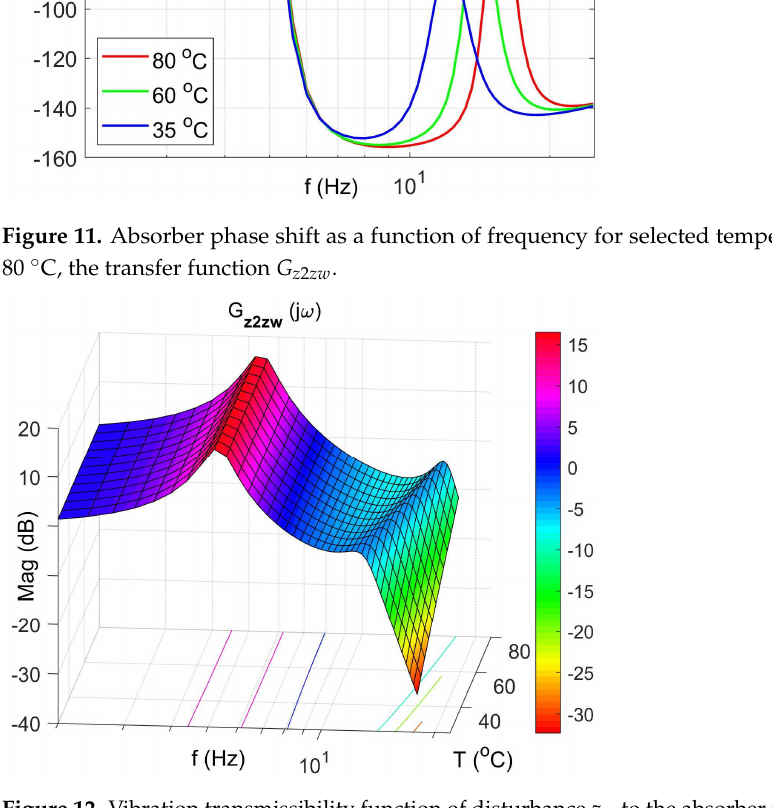
Figure 12. Vibration transmissibility function of disturbance z w to the absorber mass m 2 as a function of frequency and temperature, the transfer function G z 2 zw .